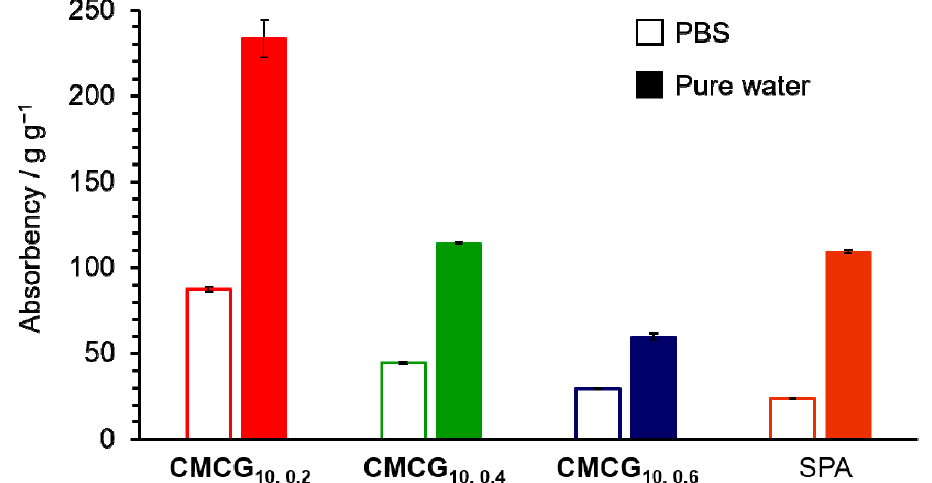
Figure 6. Absorbency of the CMCGs and SPA toward PBS (open column) and pure water (closed column) after 48 h.